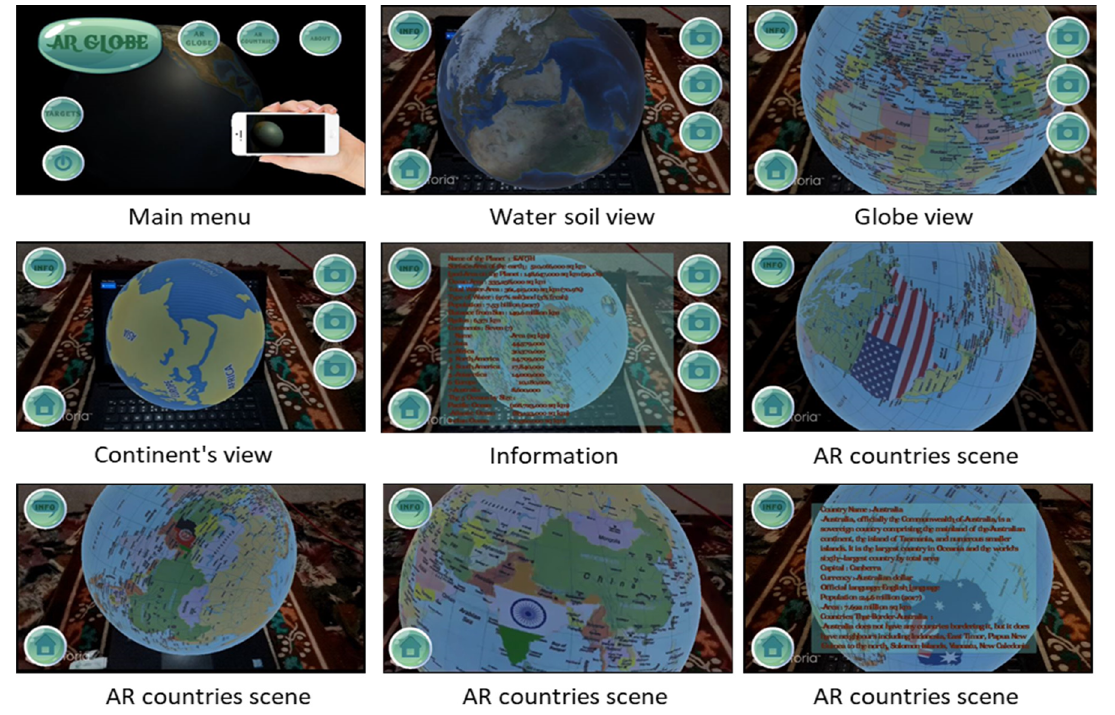
Figure 8. Different AR camera scenes of the AR Globe application where the 3D globe is augmented on the camera preview.